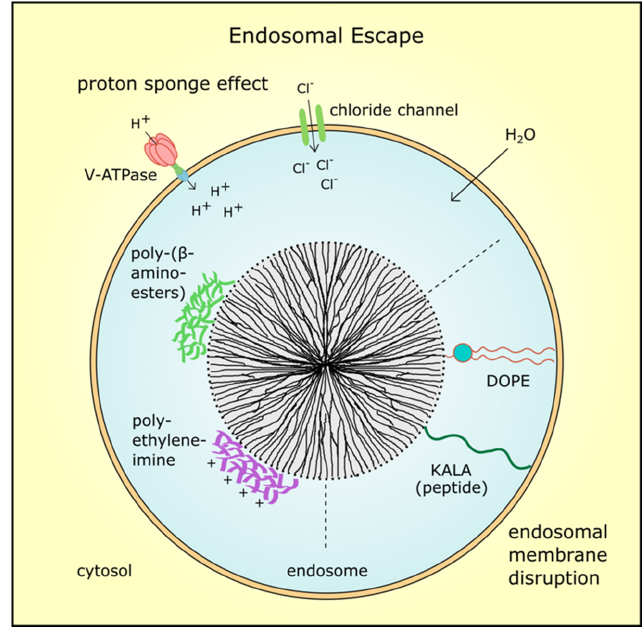
Figure 3. Endosomal escape mechanisms. After MSN were taken up by endocytosis, an endosomal escape is mandatory for drug efficacy. Coating with cationic polymers such as polyethyleneimine or poly-( β -aminoesters) induces the proton sponge effect. The proton concentration increases during